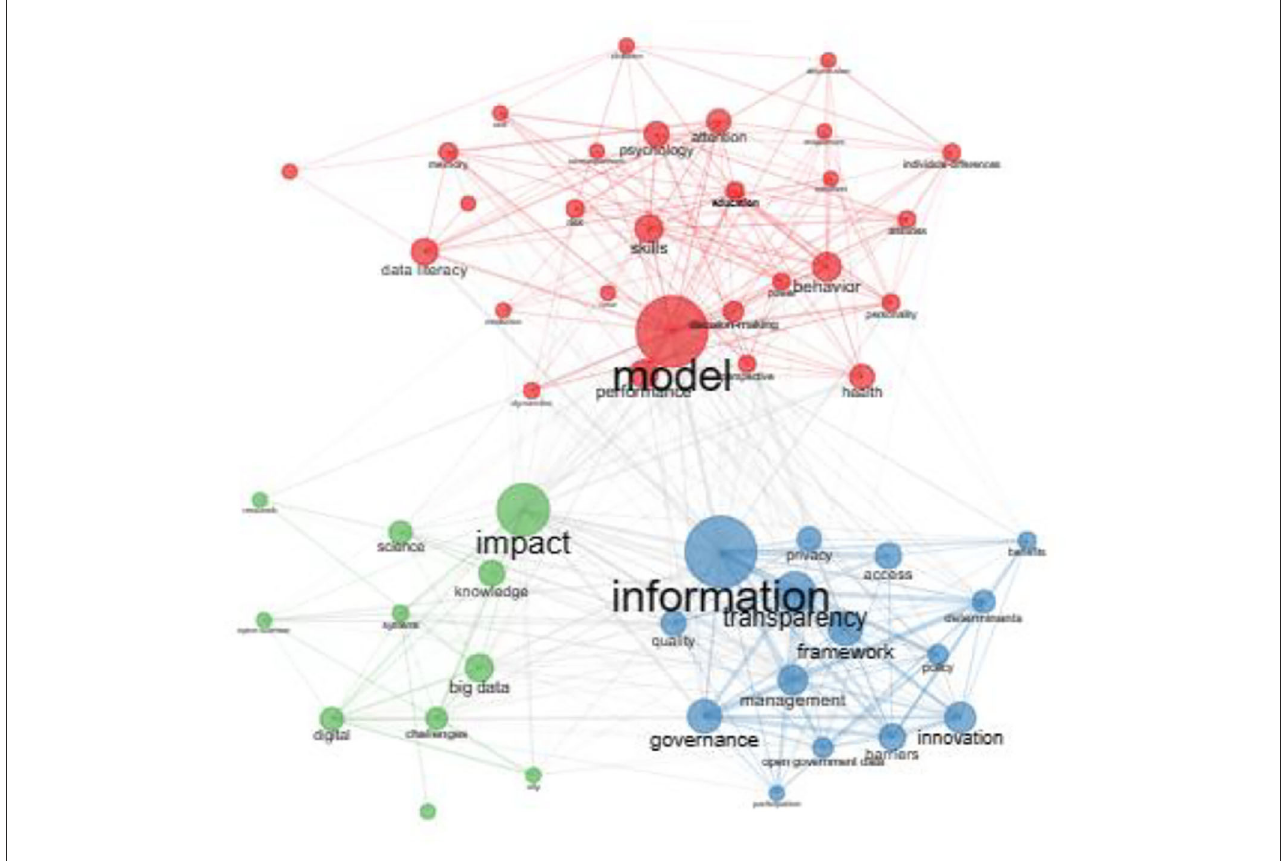
FIGURE2 Authors’ keyword co-occurrence